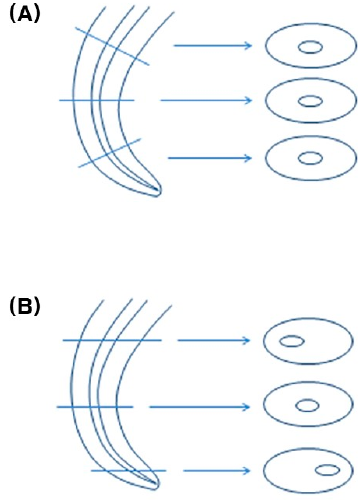
Figure 1. Slice of reconstructed image. ( A ) When sliced perpendicular to the long axis of the root canal, no distortions are produced. ( B ) When sliced perpendicular to the long axis of the tooth, distortions are produced in the images of the root canal and surrounding dentin.